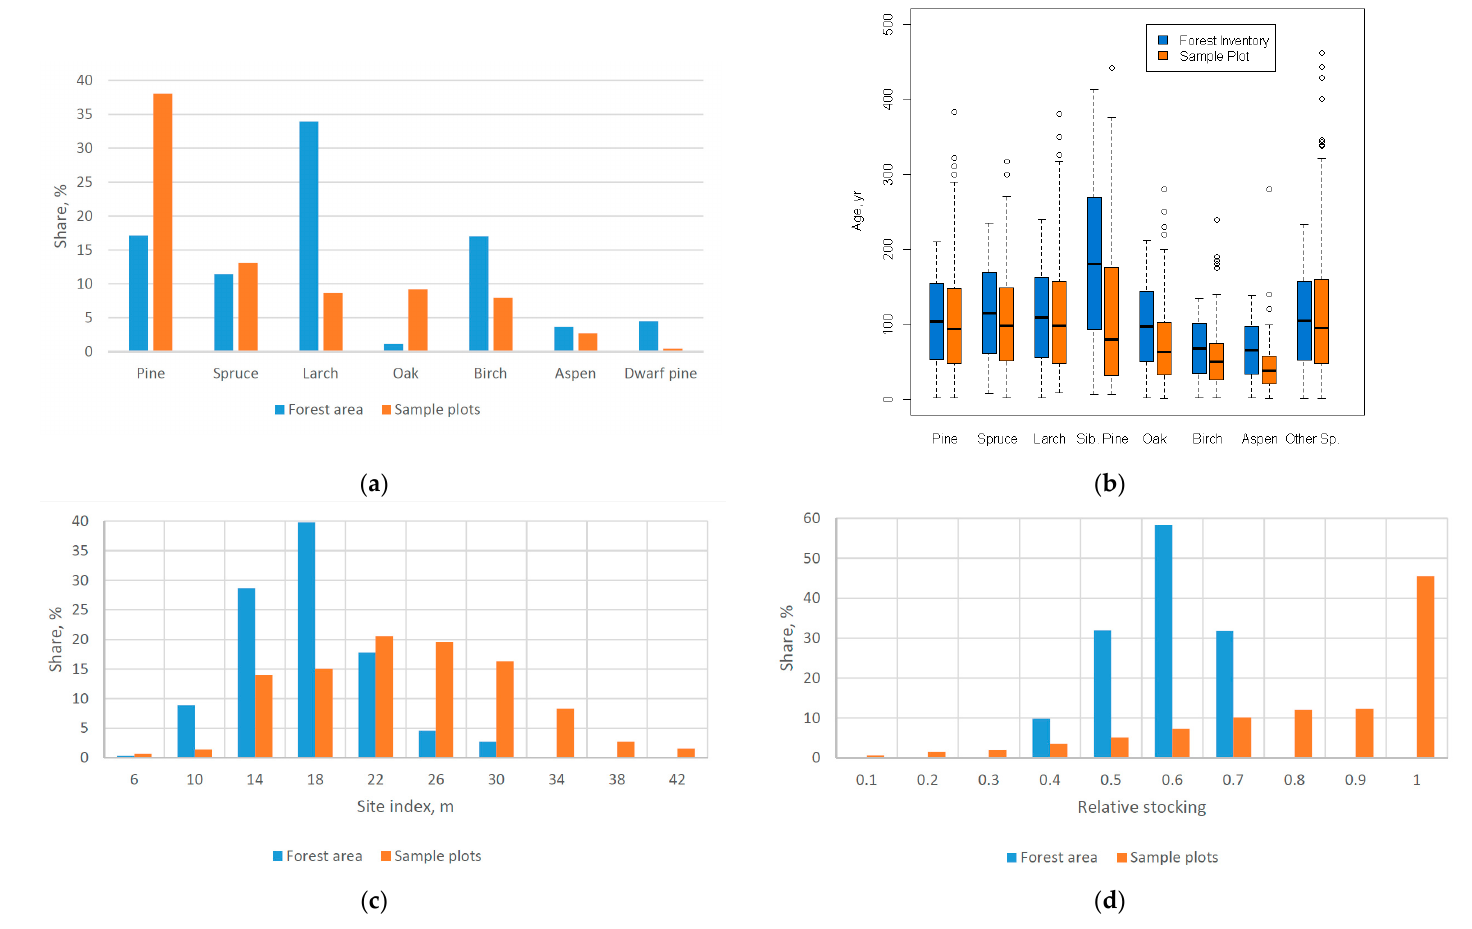
Figure 6. Discrepancy in sampling: ( a ) the amount of sample plots by dominant tree species, ( b ) the age by dominant tree species, ( c ) the distribution of sample plots by site index and ( d ) the relative stocking. Total amount of sample plots is 8007, forest area—763 million hectares.